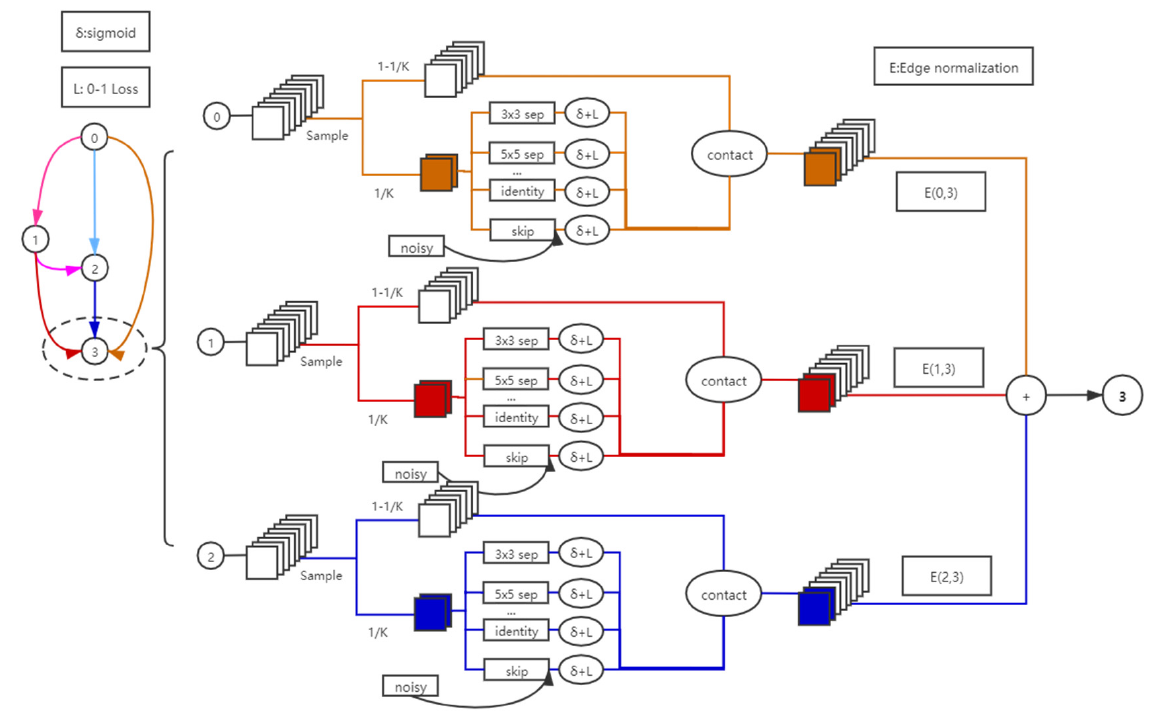
Figure 1. Illustration of the proposed approach (best viewed in color), RS-DARTS.